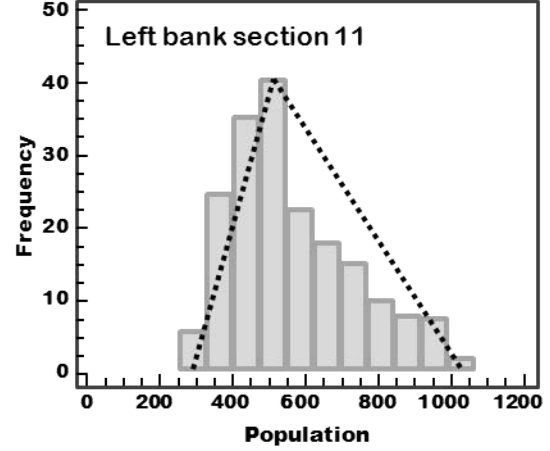
Fig. 7. Examples of FTNs.